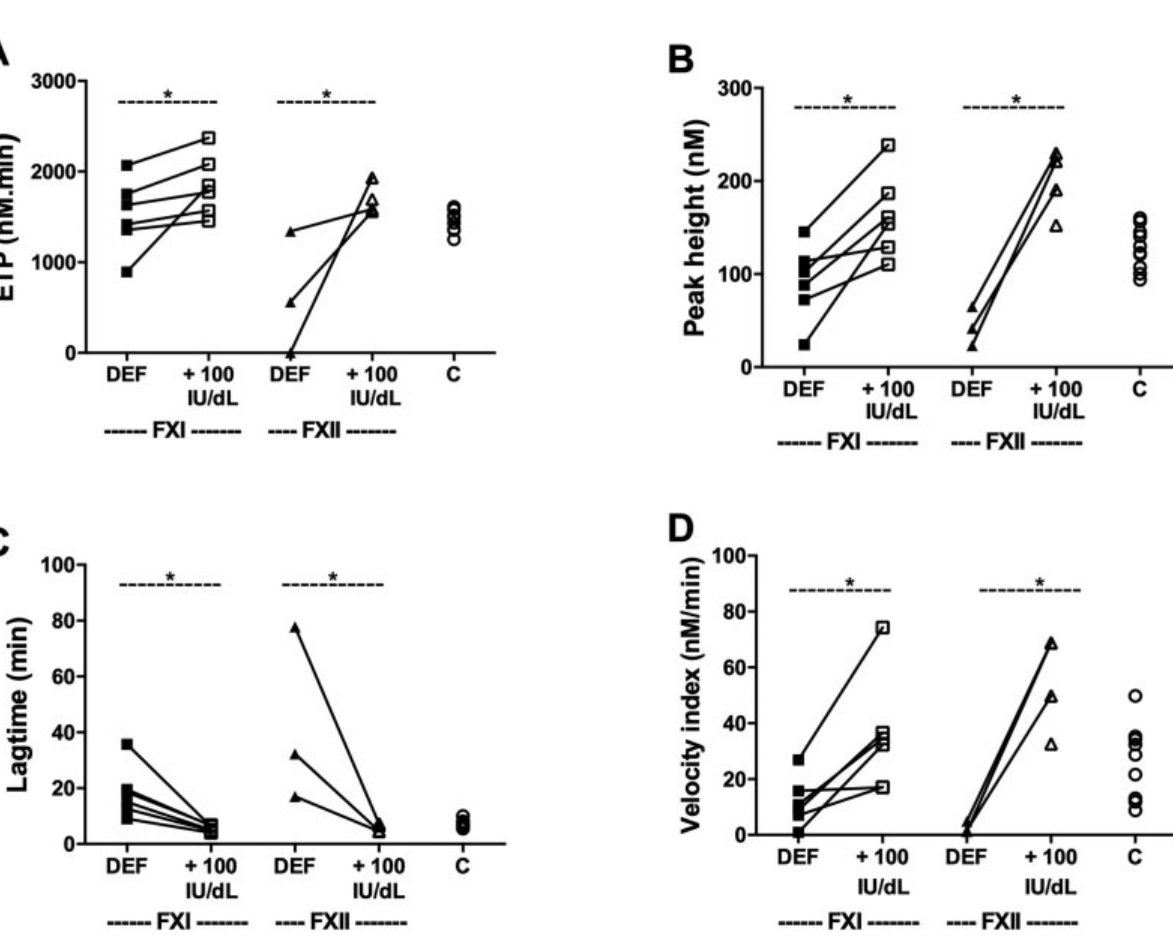
Fig. 1 Impaired thrombin generation after triggering the intrinsic pathway in platelet-rich plasma (PRP) from patients improved by factor addition. Thrombin generation in PRP from indicated controls (C) or FXI- or FXII-de fi cient patients. Triggering was with CaCl 2 and 4 μ mol/L sulfatides. Where indicated, puri fi ed FXI (6 pmol in 200µL) or FXII (75 pmol in 200µL) was preadded to PRP leading to an increase in the endogenous FXI or FXII concentration of 100IU/dL. In one FXII-de fi cient patient, no thrombin generation occurred in PRP without factor XII addition resulting in data n ¼ 3 in FXII DEF instead of n ¼ 4. The following curve parameters were assessed: ETP (endogenous thrombin potential) ( A ), thrombin peak height ( B ), lagtime to thrombin generation ( C ), and velocity index ( D ). (cid:1) p < 0.05 vs. no factor addition (Kruskal – Wallis